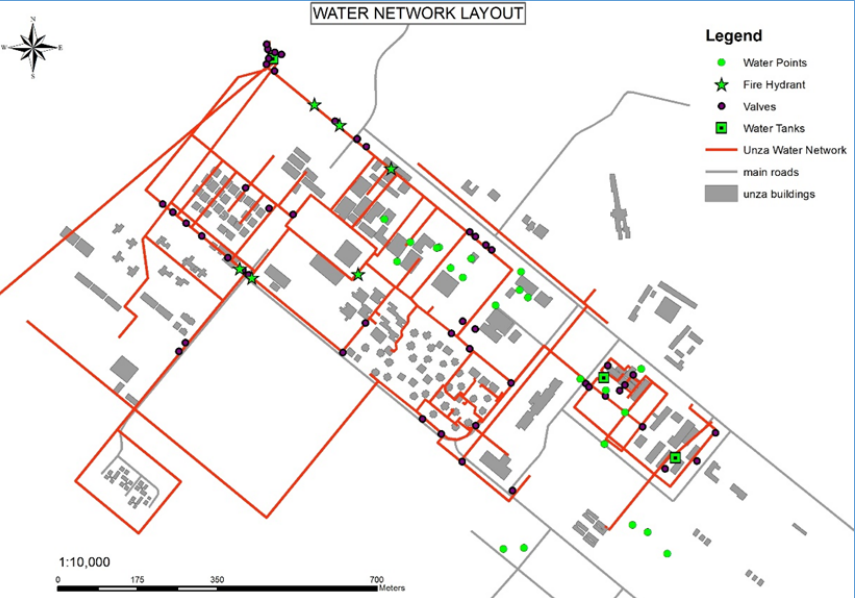
Fig. 8. Updated Water Network